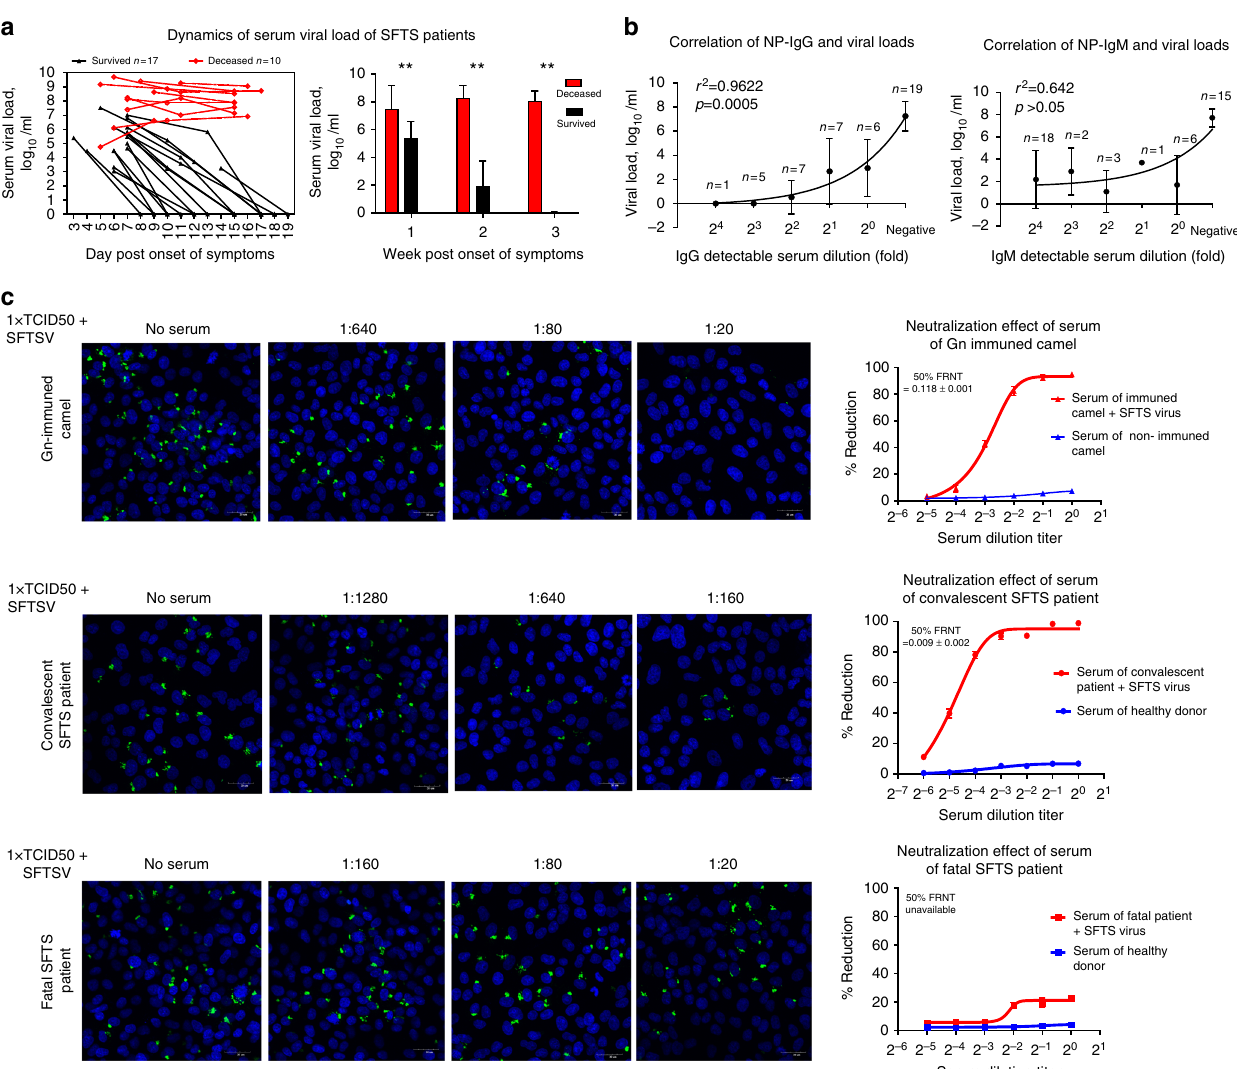
Fig. 2 Correlation between serum viral load and virus-speci fi c antibodies. a Serum viral load of 17 survived and 10 deceased patients at different day point was determined by RT-PCR, and then their kenetics of viremia during acute phase of SFTS was generated in the left panel. The level of serum viral load of the survived and deceased group during the 3-week clinical course was compared using T test in the right panel, ** p < 0.005. b Linear regression analysis of correlations between viral load and NP-speci fi c antibodies. X -axis denotes the dilution fold of the patients ’ serum samples that gives detectable signal of NP-speci fi c antibodies, and negative means undetectable antibodies at any dilution fold. r and p indicate the correlation coef fi cient and the p value of signi fi cance, respectively. p < 0.05 is considered as signi fi cant. c Neutralization of SFTSV by sera from the Gn-immunized camel, convalescent and fatal patients were shown by fl uorescence staining (left panel), and percentage of infection reduction as indicated in 50% FRNT value (right panel). Non-speci fi c neutralization effects of both human and camel sera were shown in blue. The data were from two independent experiments, and each data point from duplicate wells (means ± s.e.m). Error bar represents the standard Supplementary Fig. 3. The kinetics of PBs and MBs as de fi ned by CD38 shown in Fig. 4b were highly consistent with the result of Figs. 3d, e. PBs of the survived patients elevated signi fi cantly in the 1st and 2nd weeks post symptom onset as compared with the healthy control, and subsequently decreased to normal level in the 3rd week. The similar phenomenon was also reported in Ebola virus infection 25 . The magnitude of PB expansion in the deceased group was markedly higher than that in the survived group during all three weeks. The proportion of MBs showed no sig- ni fi cant differences between the two groups of patients as shown in Fig. 4b. Analysis of immunoglobulin expression by FACS demon- strated no signi fi cant differences in class-unswitched IgM + IgG − PBs among three groups (Fig. 4b). However, class-switched IgM